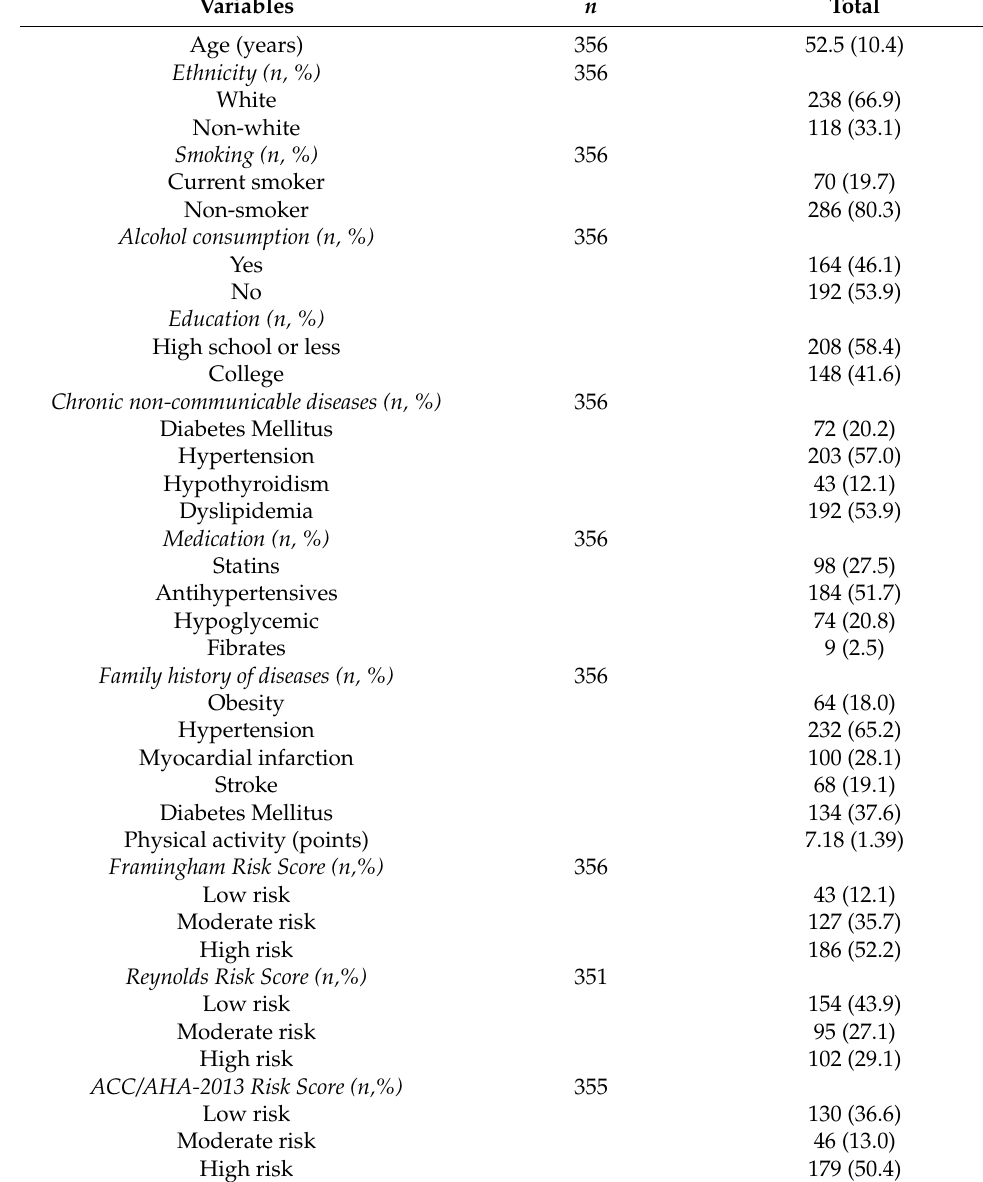
Table 1. Demographic and clinical characterization of